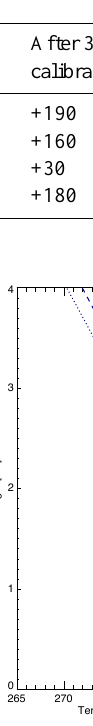
in Fig. 7, which are defined by the sensitivity of the re- trieved value at height with index i to the true value at height j ( δT retrieved ,i / δT true ,j ) . Note, a perfect vertical resolution would give rise to a delta function with a value of 1 at height i = j and 0 at all other heights i 6= j . Thus, the broadness of the averaging kernels gives information on the vertical reso- lution. The diagonal components of the averaging kernel ma- trix A correspond to the DOF for each level and the trace of the averaging kernel matrix yields the total DOF, which are ∼ 4 in case of the temperature retrieval. If the cumulative dis- tribution of the DOF with height is regarded (Fig. 7), one can conclude that about 85 % (95 %) of the temperature informa- tion originates from the lowest 2 km (4